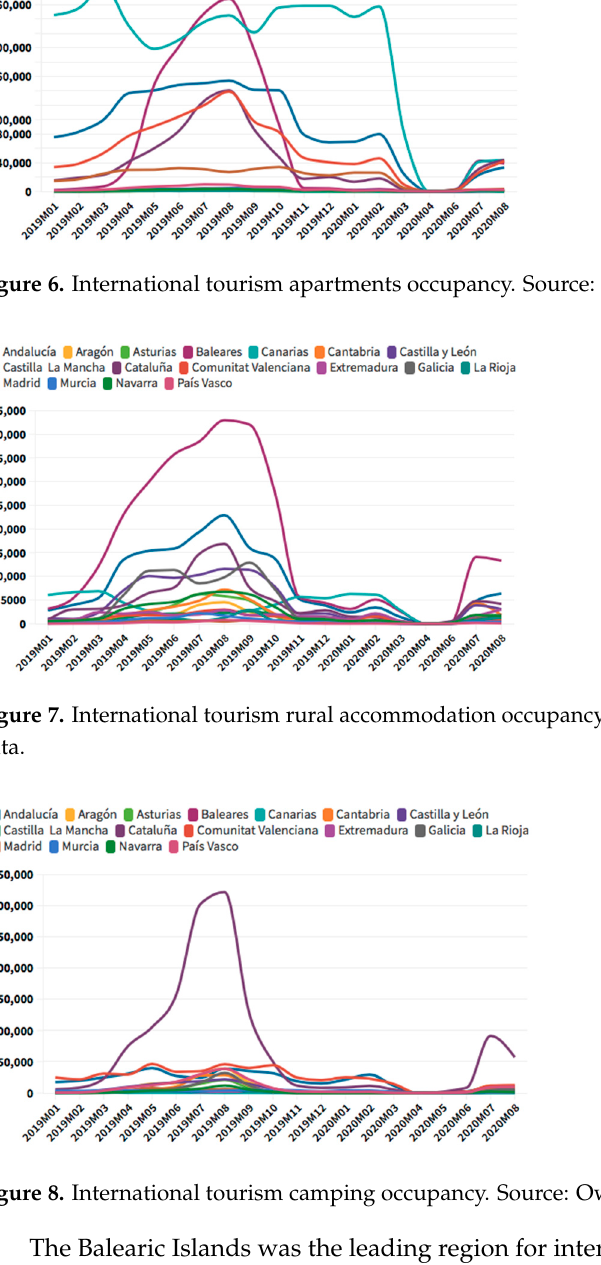
Figure 5. International tourism hotel occupancy. Source: Own elaboration from INE data.